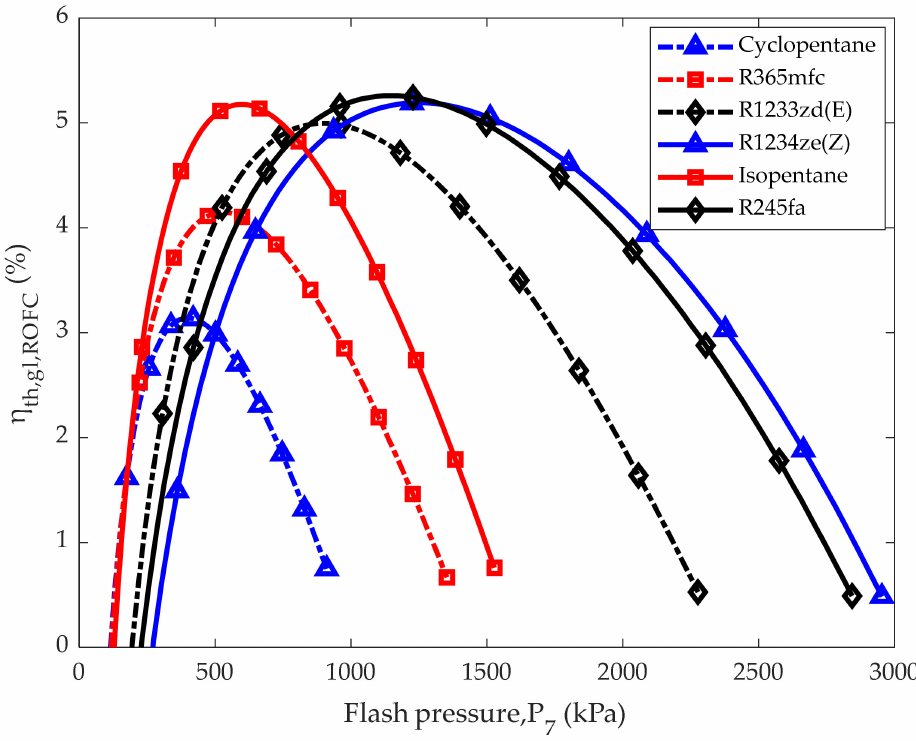
Figure 7. Effect of flash pressure on the global thermal efficiencies.